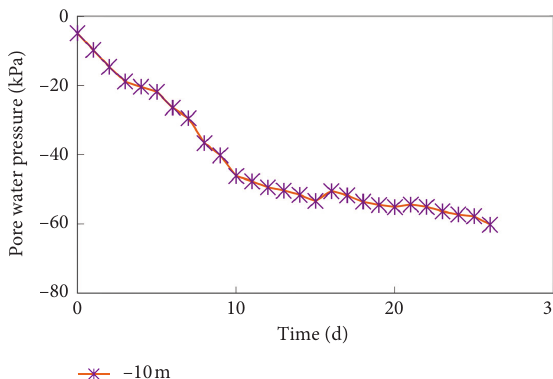
v , velocity of permeability; k , coefficient of permeability.